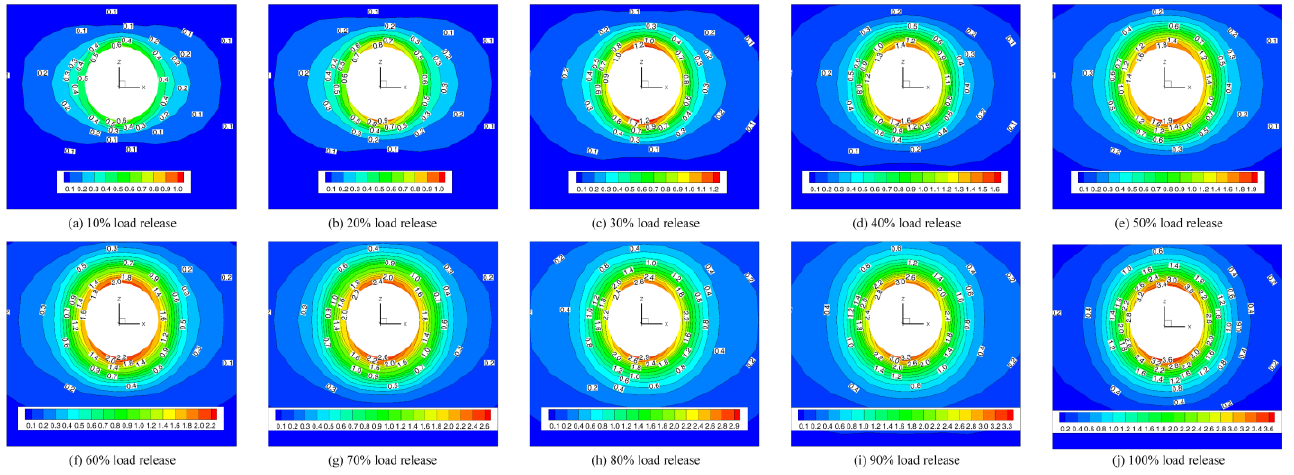
Figure 6. Contour map of tensile strain ratio of type V surrounding rock.